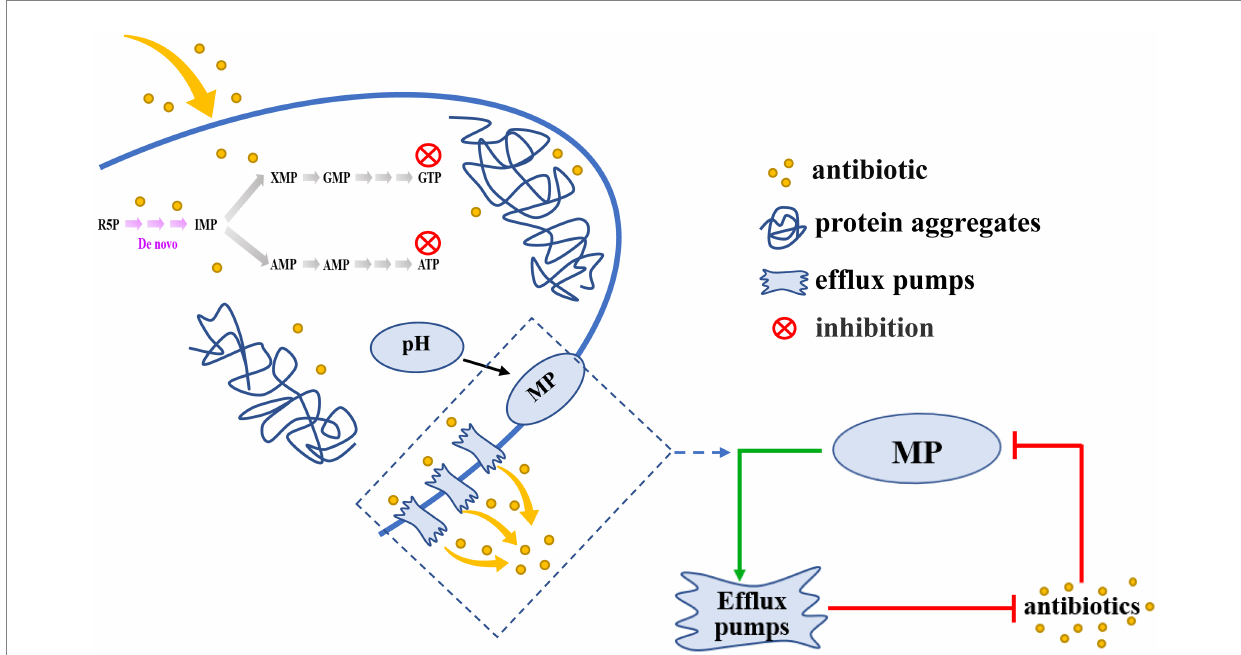
FIGURE 7 A schematic model for the inhibition of purine metabolism is associated with formation of V. splendidus persister cells. Inhibition of Purine metabolism was associated with AJ01 persister cells formation, accompanied by low intracellular ATP levels and the formation of protein aggresome. Meanwhile, the decrease in purine metabolism also affected membrane potential and efflux, reducing intracellular accumulation of tetracycline. The decreased pH dissipated membrane potential (MP) to activate efflux pumps transport antibiotics out of cells. The green arrows mean promotion; red arrows mean